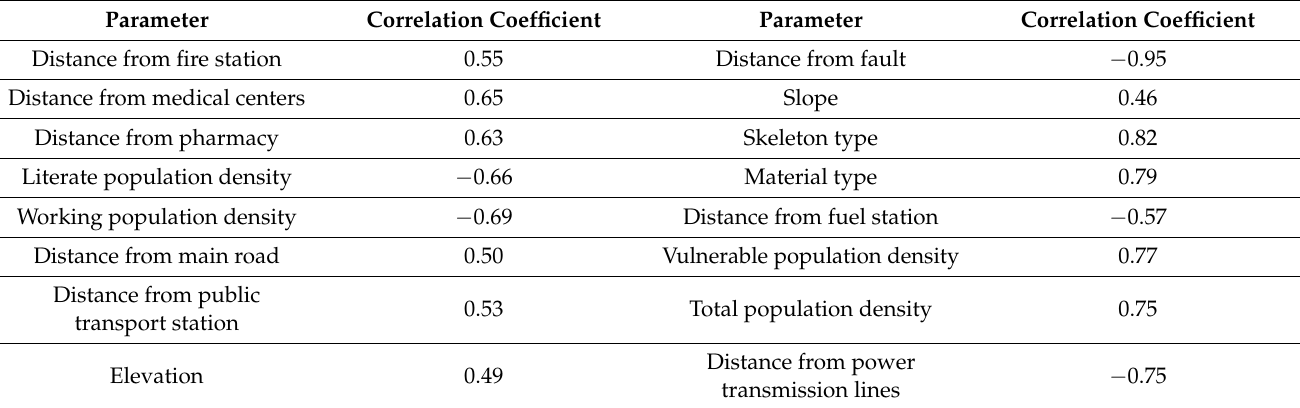
Figure 11. Earthquake vulnerability map in urban blocks using the ANP-WLC model. Higher degrees of fuzzy membership in this map indicate higher vulnerability. Table 4. Correlation between the criteria and the output of the ANP-WLC model.